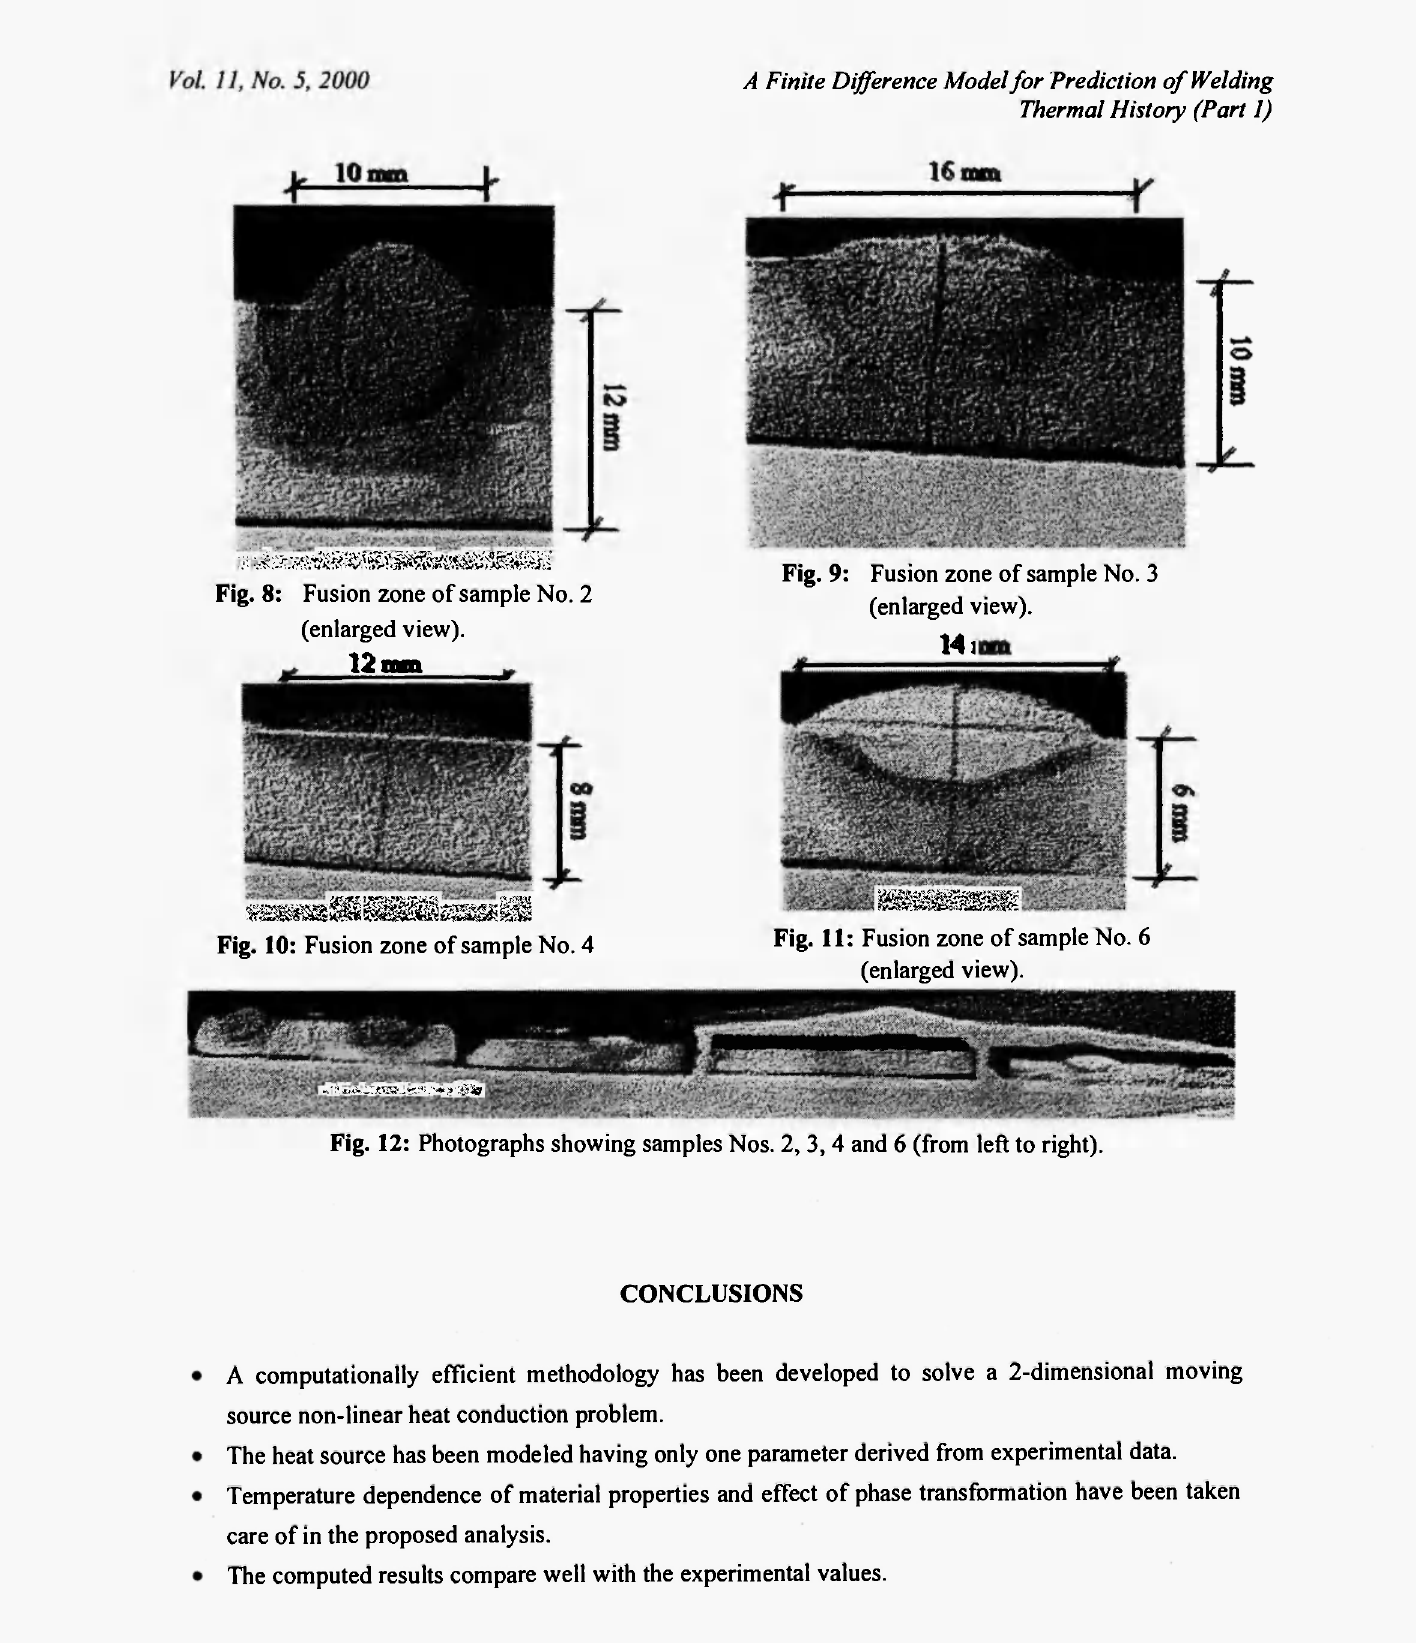
Fig. 12: Photographs showing samples Nos. 2, 3,4 and 6 (from left to